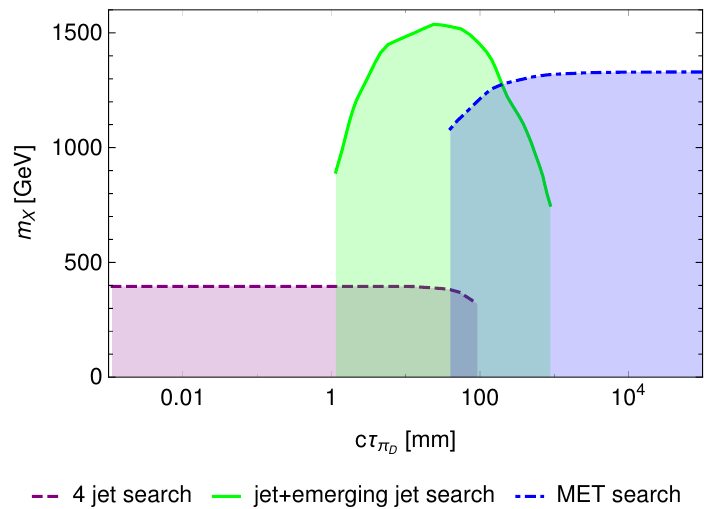
Figure 12. Constraints on the mediator mass for benchmark point B for the three searches: (i) in dashed purple: 4 jets search, (ii) in solid green: emerging jets search, (iii) in dot-dashed blue: MET search. The coloured areas are excluded by the respective search.